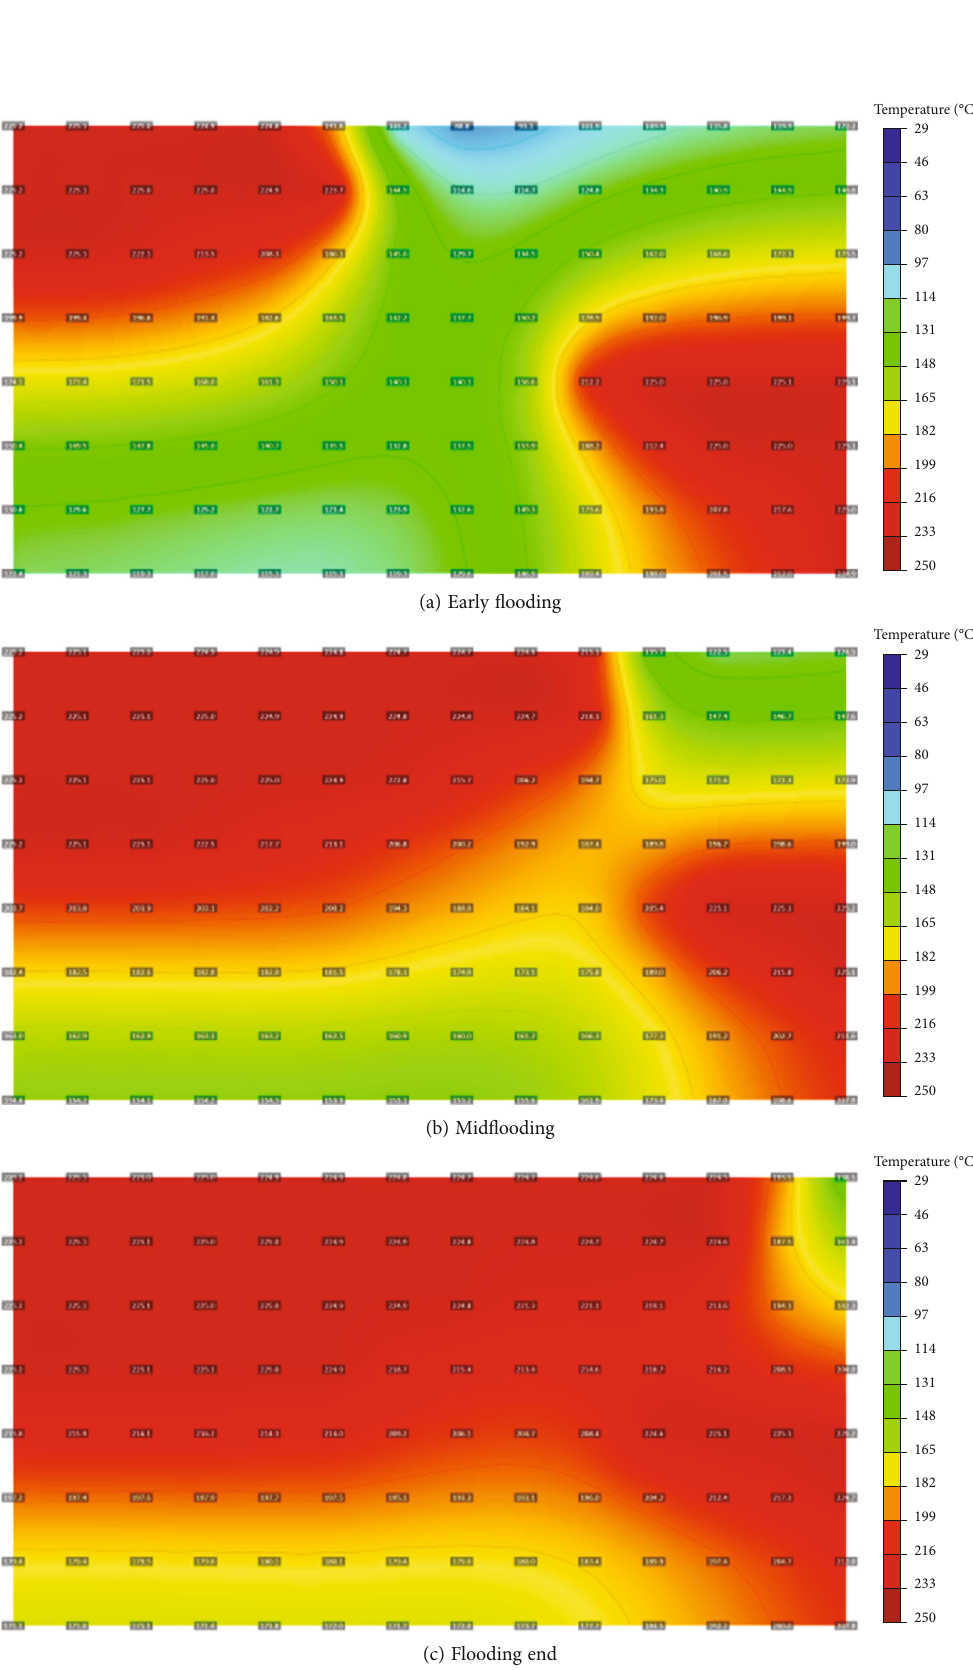
Figure 11: Temperature distribution of vertical-assisted SAGD preheated by